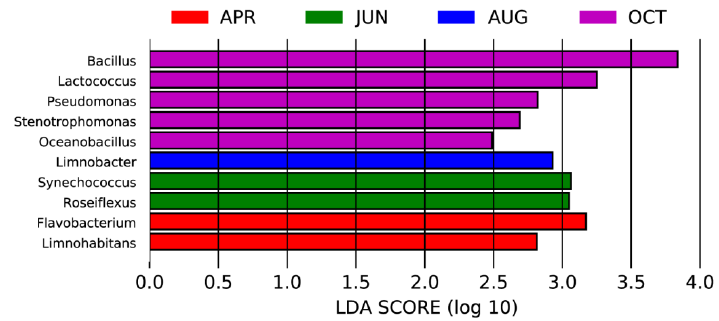
Figure 6. The seasonal biomarkers in the Miyun Reservoir as identified with LEfSe (LDA score > 2.5, p < 0.05).